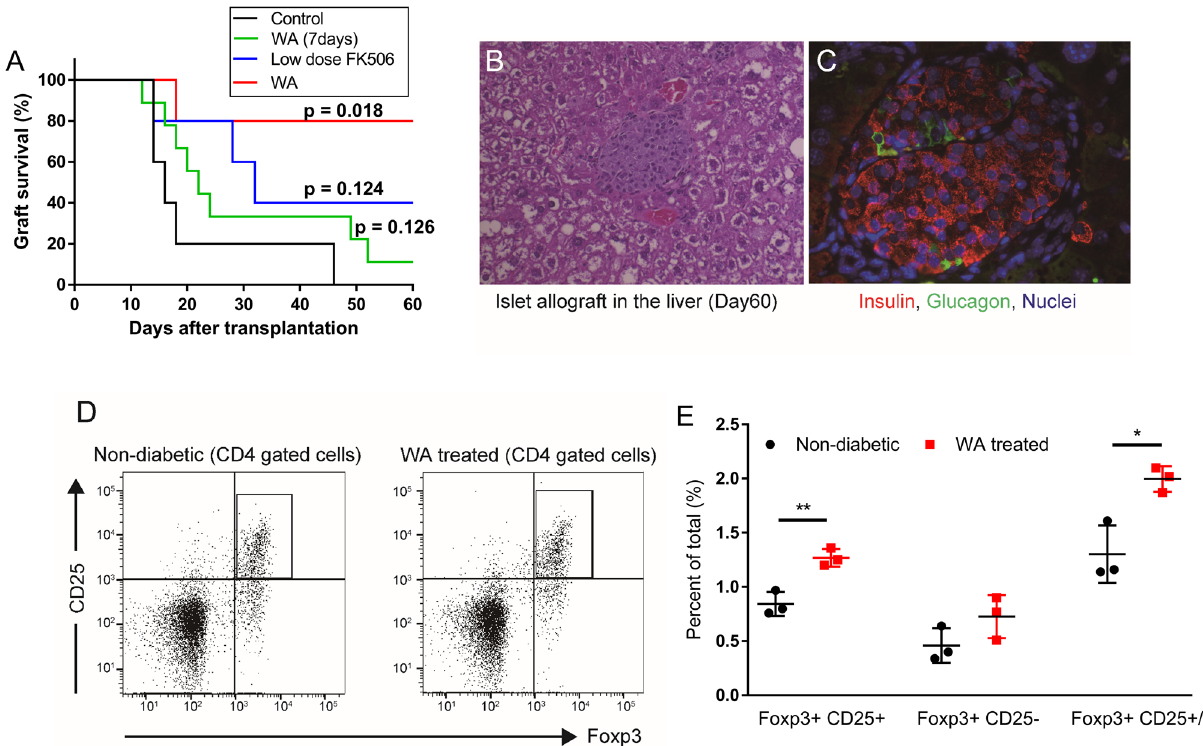
Figure 1. Effects of WA treatment on islet allograft survival. Donor BALB/c islets were isolated by collagenase containing 0.5 μg/mL WA. The islets were pretreated with WA 0.5 μg/mL for 30 min before islet transplantation, and then 300 islets were transplanted into the portal vein. ( A ) Kaplan–Meier plot for the survival of islet allografts (BALB/c to C57BL/6N) in recipient mice [n = 5 in control, low-dose FK506-treated ( P = 0.124), and 1.25 mg/kg WA-treated groups; n = 5 in 1.25 mg/kg WA daily treatment group ( P = 0.018), n = 9 in 1.25 mg/kg WA 7-day treatment group ( P = 0.126)]. ( B , C ) Histological analysis of the liver grafts of the daily WA treatment group at autopsy, 60–70 days after transplantation (left panel, hematoxylin and eosin, × 100; right panel, anti- insulin and anti-glucagon antibodies, × 400). ( D ) Flow cytometry analysis of Treg population of the spleen in the WA daily treatment group. An autopsy study of the spleen was performed at the same time as liver autopsy (n = 3). CD4 + CD25 + Foxp3 + cells are gated and compared to those of nondiabetic control mice (n = 3). ( E ) Frequency of CD4 + CD25 + Foxp3 + , CD4 + CD25 + Foxp3 − and CD4 + CD25 +/− Foxp3 + cell populations (Percent of total). * P < 0.05, ** P <